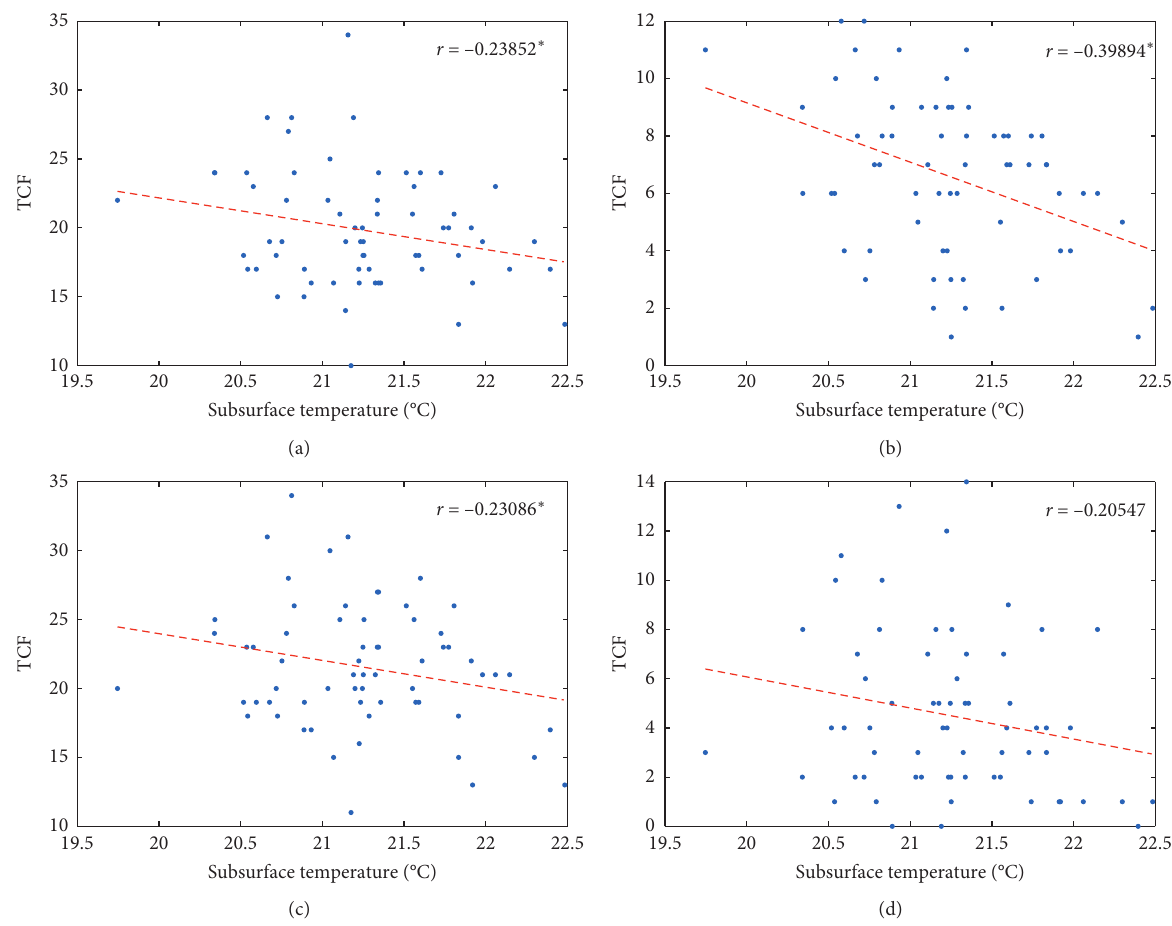
Figure 2: Scatter plots of observed (a) TCF from JTWC dataset, (b) C45 TCF from JTWC dataset, (c) TCF from CMASTI dataset, and (d) C45 TCF from CMASTI dataset from mean subsurface temperature during JASON season. The red-dotted line is the linear fitting curve, r is the correlation coefficient between TCF and mean subsurface temperature during JASON season, and the superscript ∗ indicates that the correlation is statistically significant at the 90% confidence